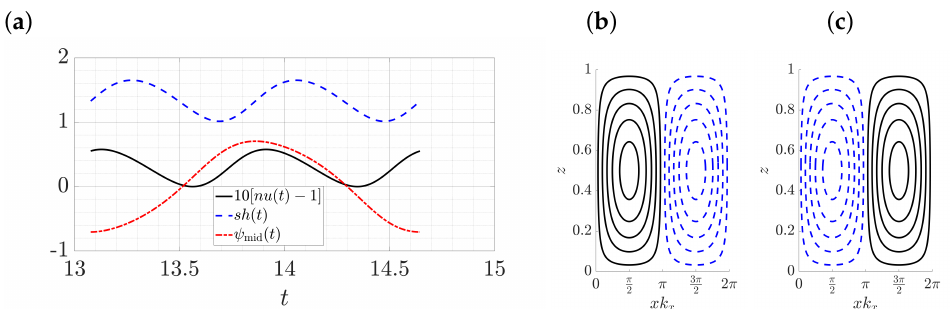
Figure 8. ( a ) One period of a standing wave computed from the single-mode equations at Ra T = 55, R ρ = 0.1, Le = 5, k x = π and k y = 0 displaying 10 [ nu ( t ) − 1 ] , sh ( t ) and ψ mid ( t ) as a function of t ∈ [ 13.077,14.645 ] with oscillation period T p = 1.568. Panels ( b ) and ( c ) show the isocontours of the streamfunction at t = 13.077 and t = 13.861, respectively. This figure is to be compared with the corresponding DNS results (Figures 5 and 6 in [43]). nu ( t ) , max sh ( t ) and the oscillation period T p of standing Table 1. Comparison of max ψ mid ( t ) , max t t t